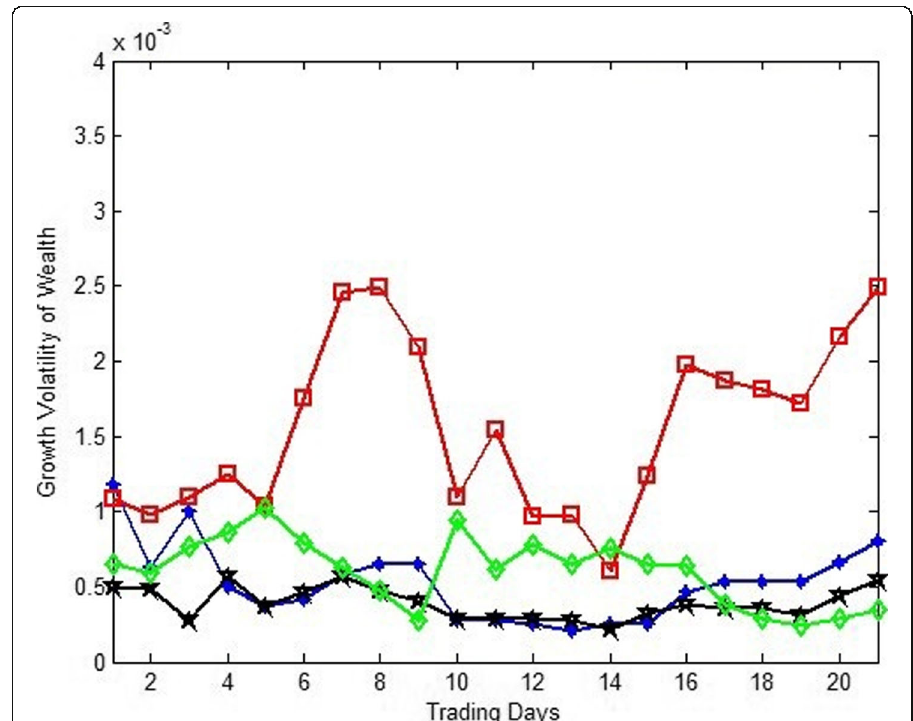
Fig. 6 Wealth growth volatility of investors. Blue line: informed traders; Red line: technical traders; Black line: noise traders; Green line: arbitrage